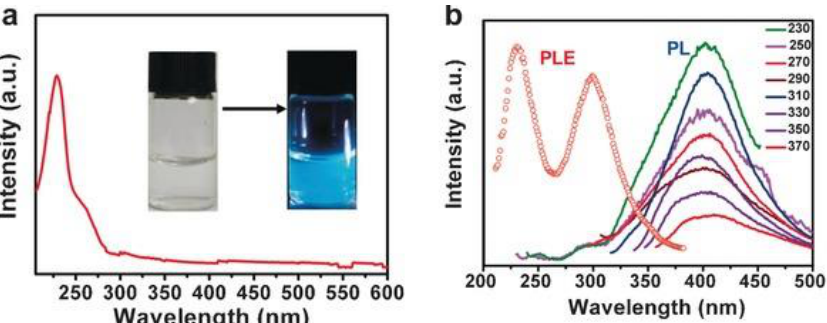
Figure 6. ( a ) UV-Vis absorption; inset: photographs of the BNQDs dispersed in aqueous solution under visible (left) and λ = 365 nm UV (right) lights. ( b ) Photoluminescence excitation (PLE) spectrum of the prepared BNQDs and excitation-independent PL emission behavior of BNQDs excited at different wavelengths from λ = 230–370 nm. Reproduced from [64] with permission from 2016 Wiley-VCH Verlag GmbH & Co. KGaA (Weinheim, Germany).